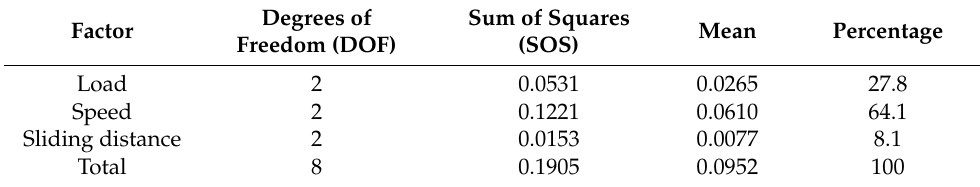
Table 6. ANOVA study of grey rational grade.